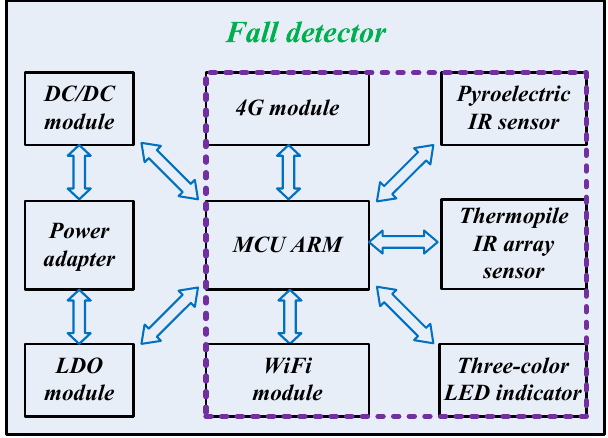
Figure 1. System architecture of an intelligent fall detector.